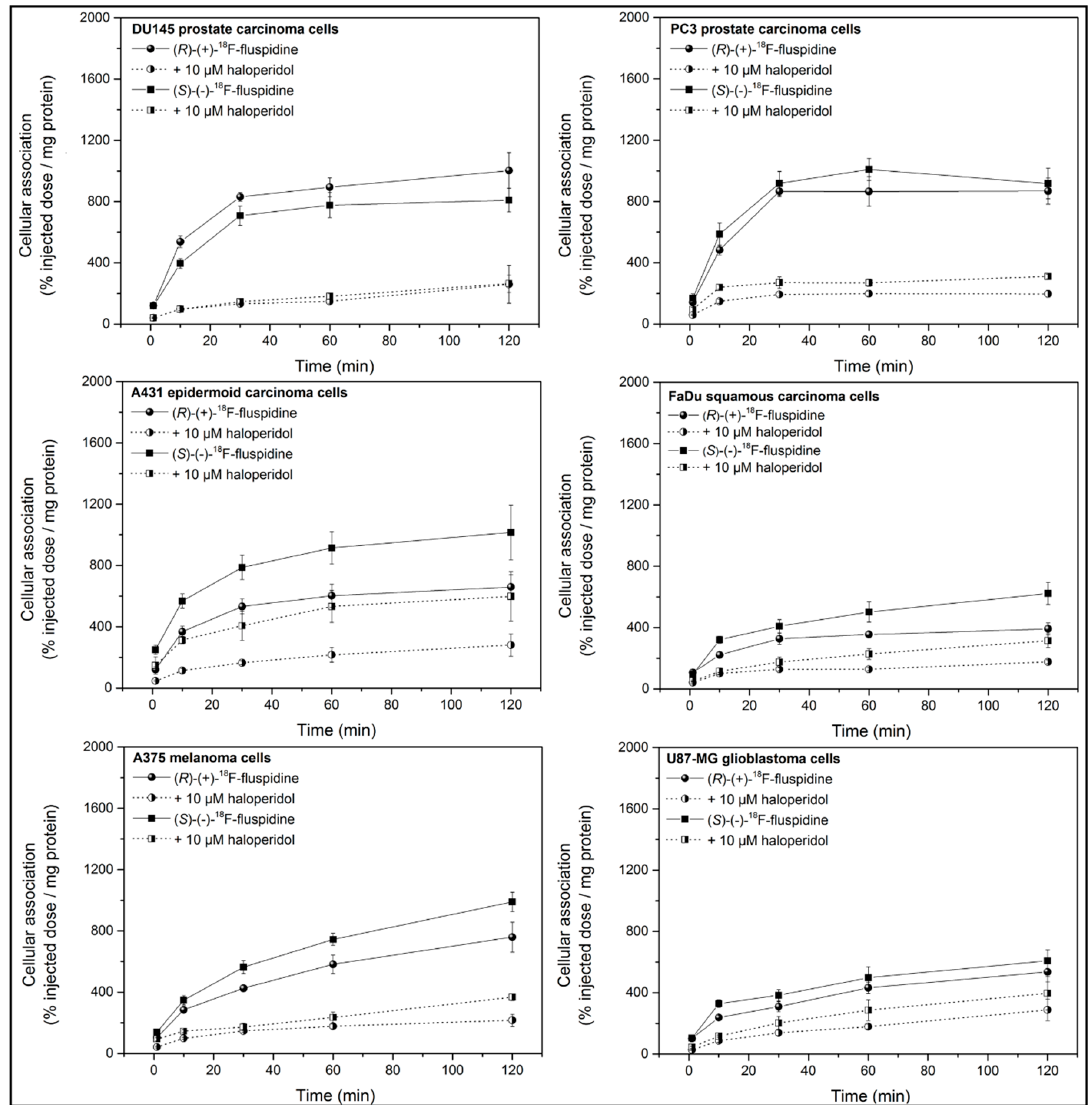
Figure 2. Cellular accumulation of ( S )-( − )- and ( R )-(+)-[ 18 F]fluspidine in the human tumor cells DU145, PC3, A431, FaDu, A375, and U87-MG in vitro. Blocking experiments were performed by preincubation (for 10 min) with 10 µM haloperidol. Results are given as percentage of injected dose (%ID) per mg protein (mean ± SD; n ≥ 8 for ( R )-(+)-[ 18 F]fluspidine and n = 7 for ( S )-( − )-[ 18 F]fluspidine).